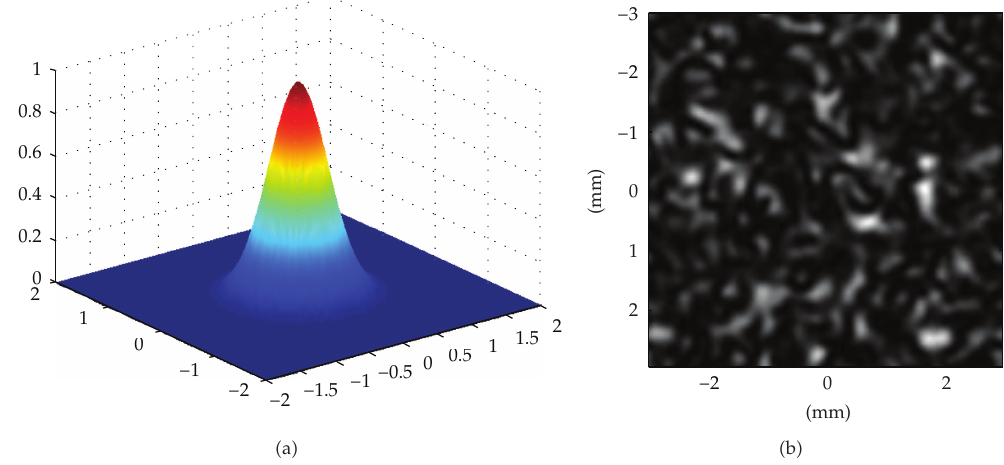
Figure 4: (cid:3) a (cid:4) Gaussian beam with optical field U (cid:3) ξ,η (cid:4) (cid:5) U 0 exp (cid:6) − (cid:3) ξ/ω (cid:4) 2 − (cid:3) η/ω (cid:4) 2 (cid:7) and beam radius ω . (cid:3) b (cid:4) Speckle pattern in the photodetector plane generated by a Gaussian